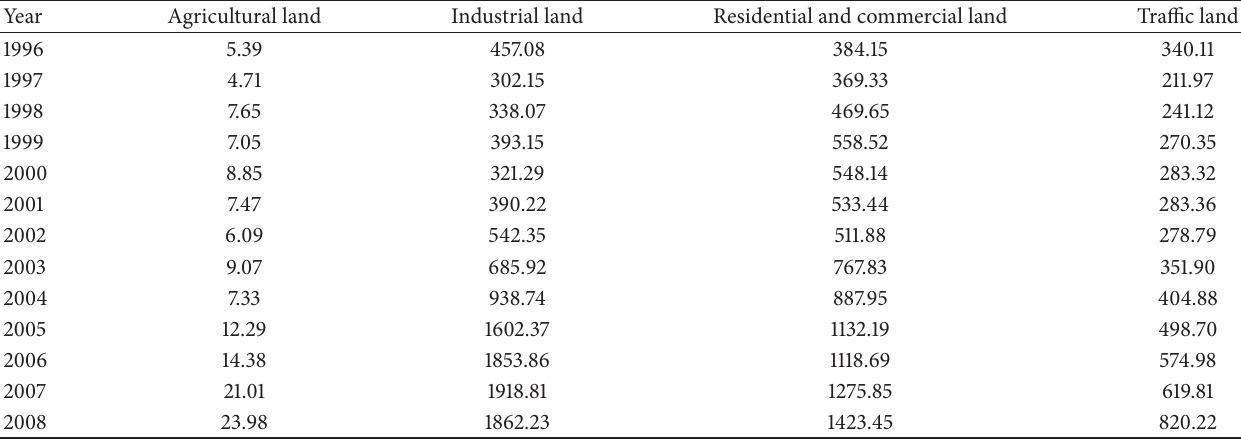
Table 11: Input capital in different types of land use (100 million Yuan).